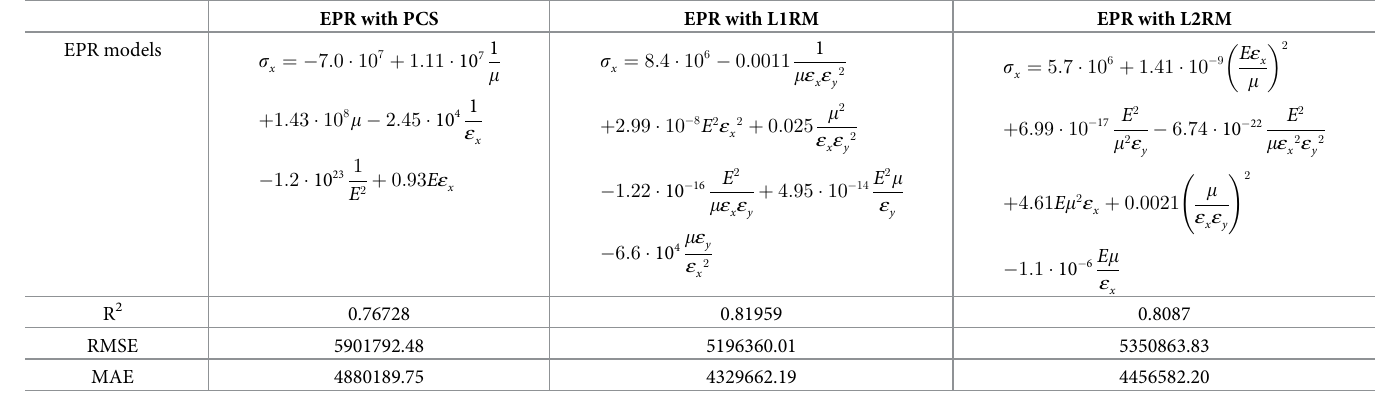
Table 7. Prediction performance of 3 EPR models in dataset 4.